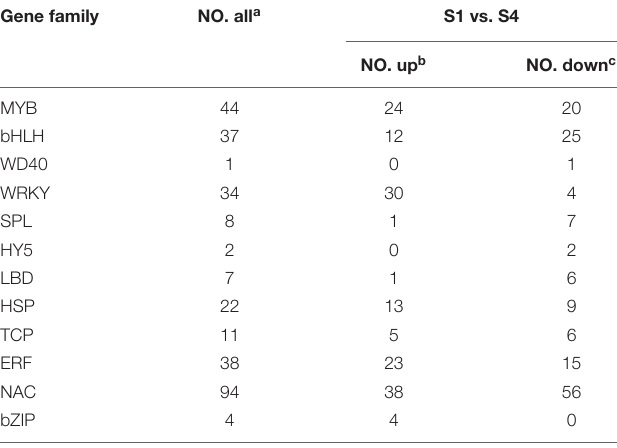
a Indicates the total number of regulatory genes in differentially expressed genes. b Indicates the number of upregulated genes in each comparison. c Indicates the number of downregulated genes in each comparison. All candidate anthocyanin regulatory genes in this table are screened from differentially expressed genes.